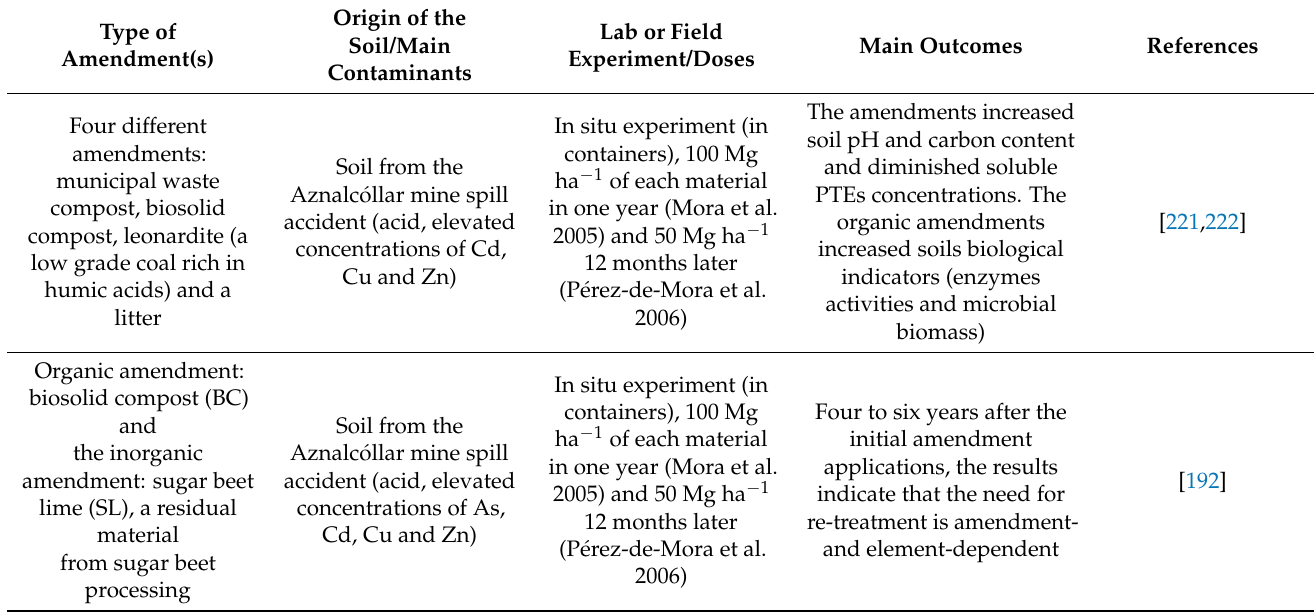
Table 4. Examples of combination of amendments used in the remediation of soils affected by mining activities in the IPB, or in similar edaphoclimatic conditions, application doses, soil characteristics, and important